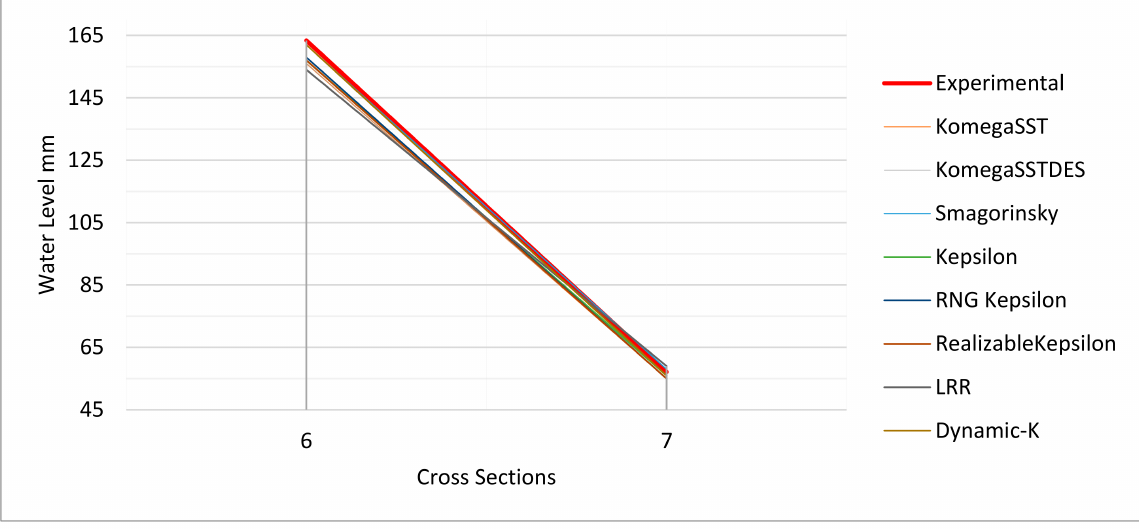
Figure 6. Comparison of experimental water level results (obtained with the average measuring error of 1.93–2.58%) with the numerical simulation results for the discharge of 10 L/s (for cross-sections 6 and 7).